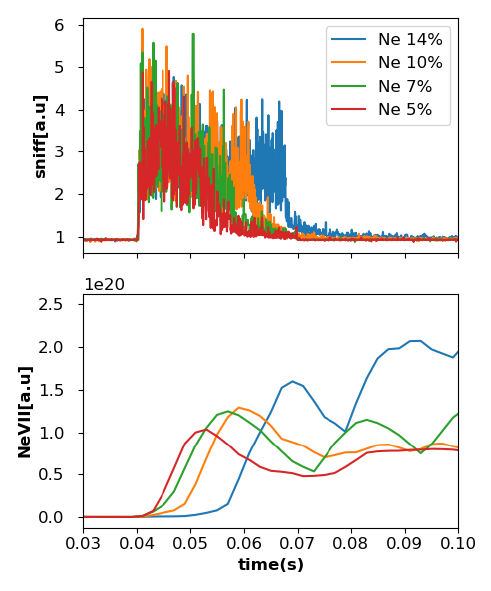
Figure 4. Variation of B tor in the range 2.2-2.6 T, ECH power 1.4 MW, Ne / D = 7%. Top: Position of the current center dur- ing EC pulse. Horizontal lines correspond to radial position of cold resonance at corresponding fields. Bottom: stray radiation measurements